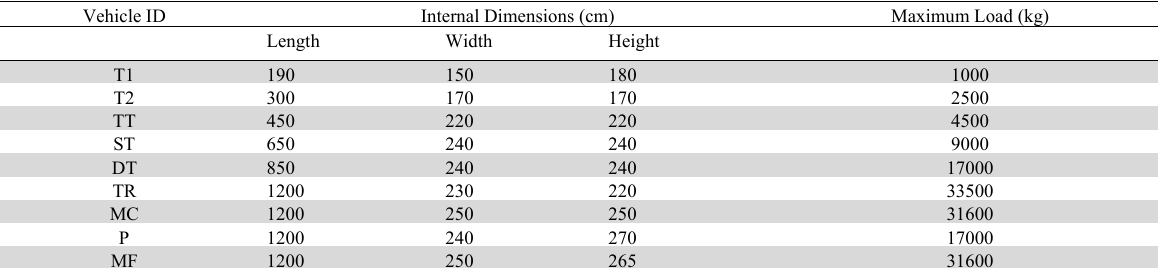
Available Vehicles Vehicle ID Internal Dimensions (cm) Maximum Load